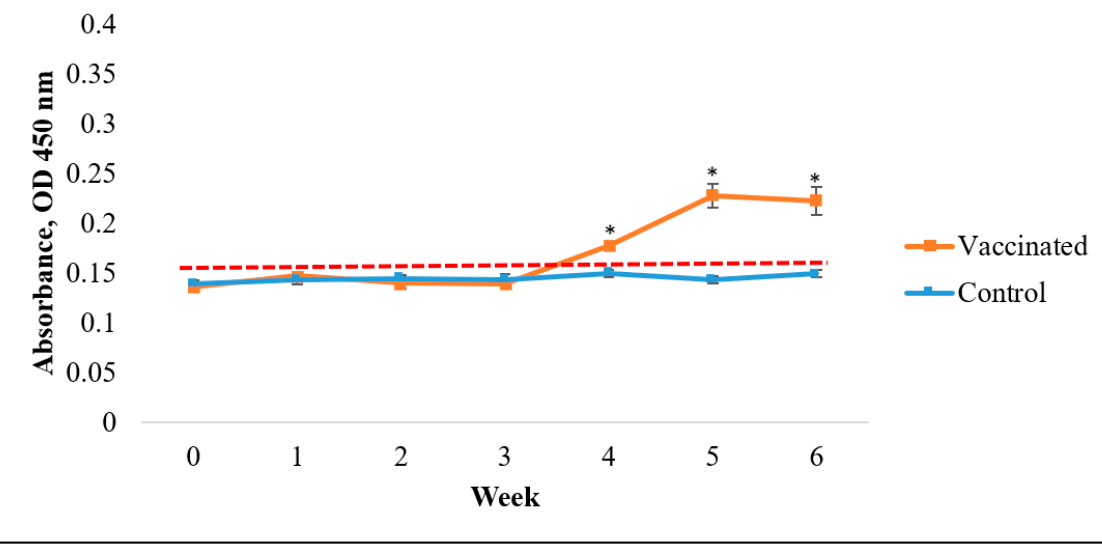
Figure 6. Specific antibody (IgM) levels against S . agalactiae in vaccinated Asian seabass (mean ± SE, n = 6) 6 weeks post ‐ vaccination. Asterisks indicate a significant difference ( p < 0.05) from the control.